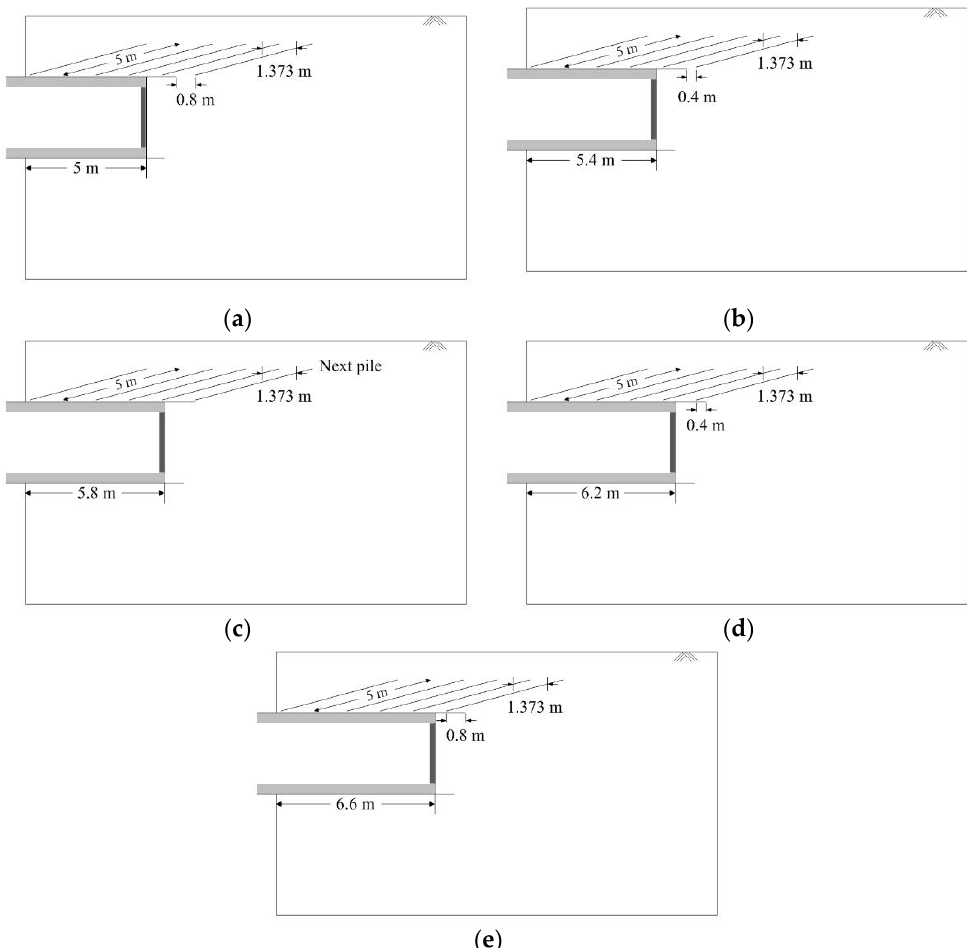
Figure 12. Location of piles according to progress of construction: ( a ) initial state of first cycle. ( b ) Initial state of second cycle. ( c ) Initial state of third cycle. ( d ) Initial state of fourth cycle. ( e ) Initial state of fifth cycle. Appl. Sci. 2020 , 10 , x 12 of 19